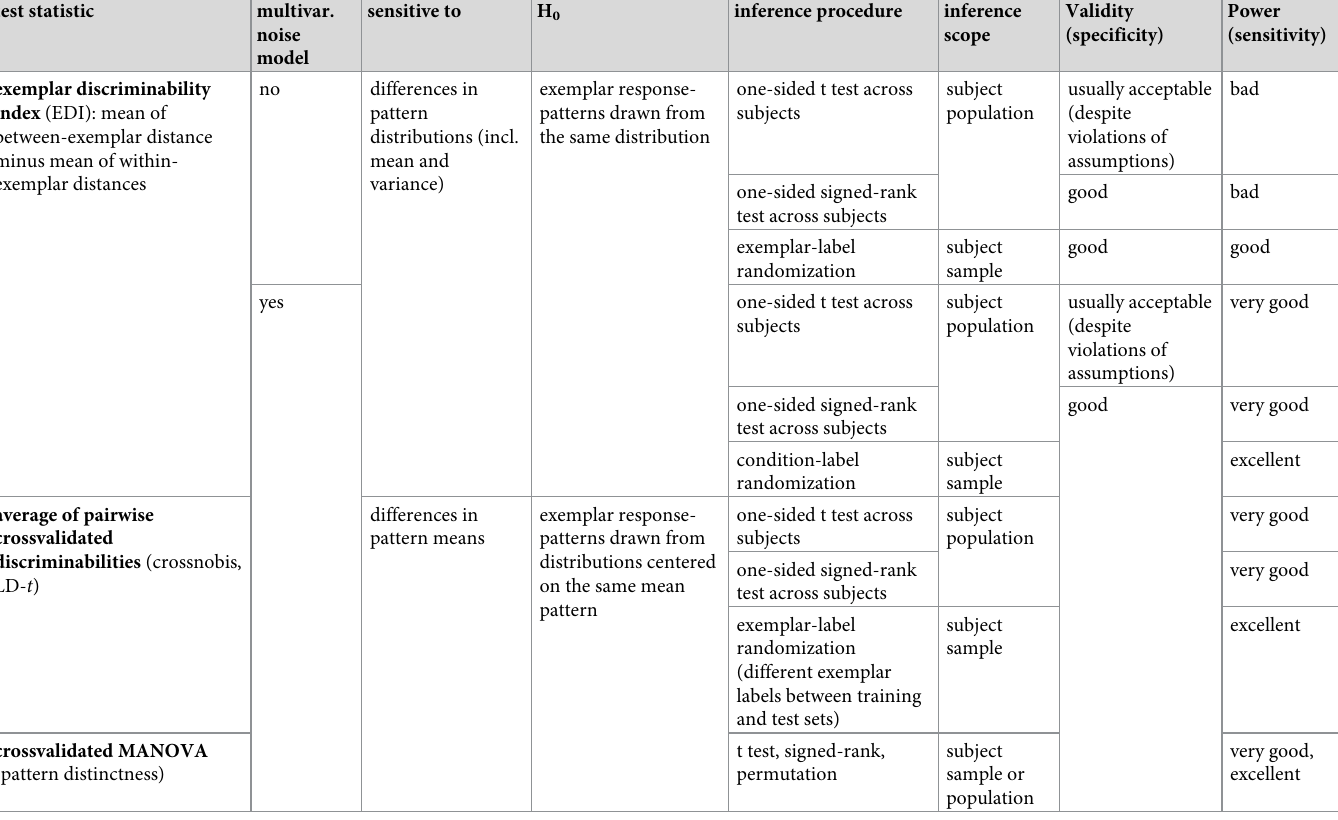
Table 1. An overall view of different methods for testing exemplar